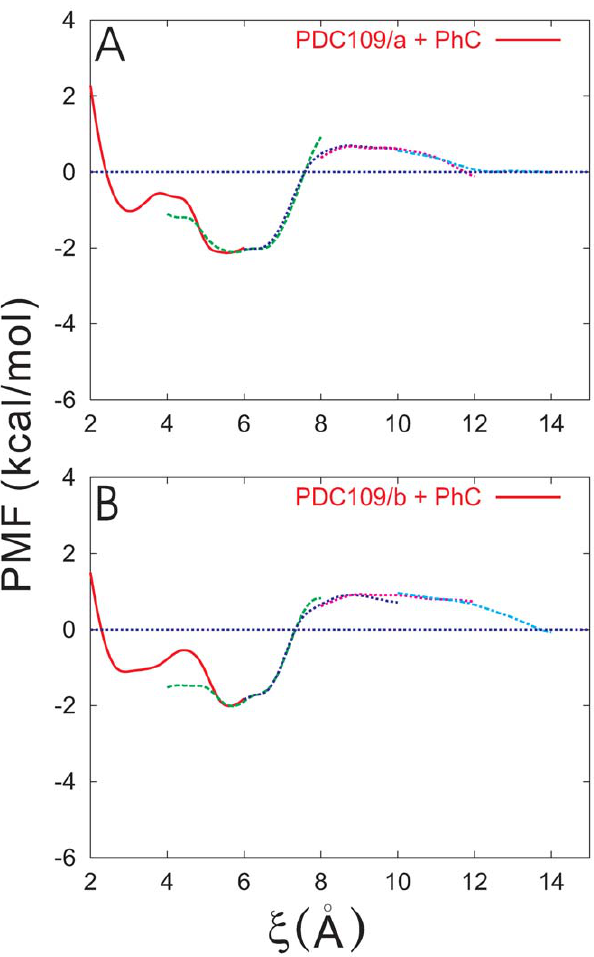
Figure 6. Full MD results for PMF profiles. PMFs for PDC109/a (A) and PDC109/b (B) are displayed, including those in overlapping regions of windows.